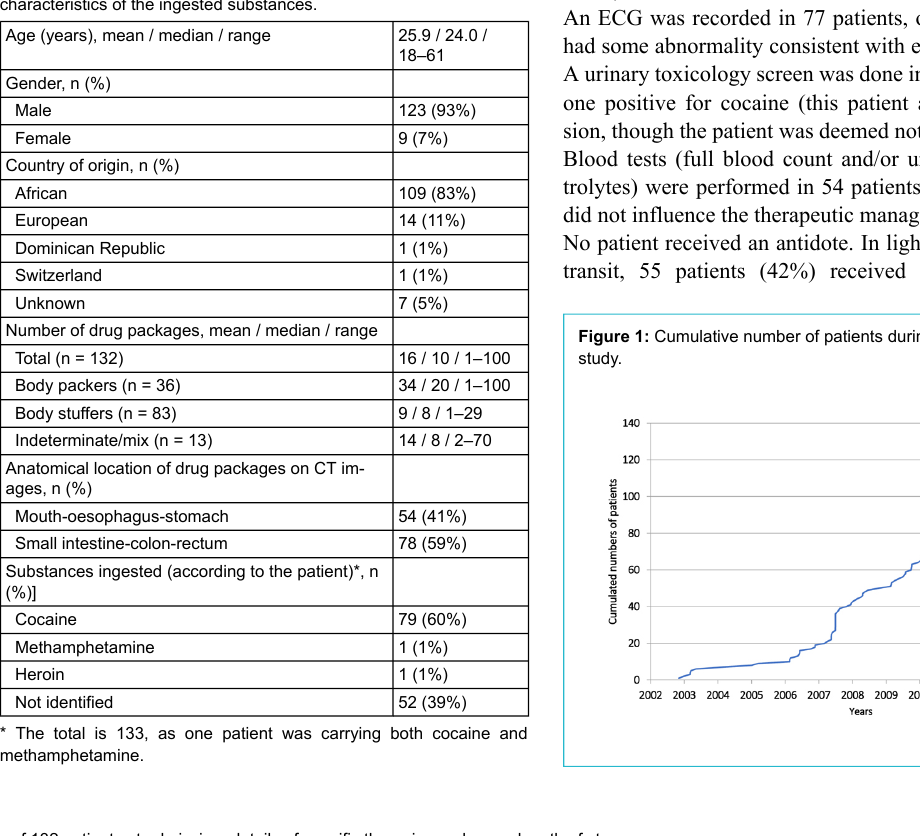
Table 2: Clinical characteristics of 132 patients at admission, details of specific therapies and mean length of stay. Clinical